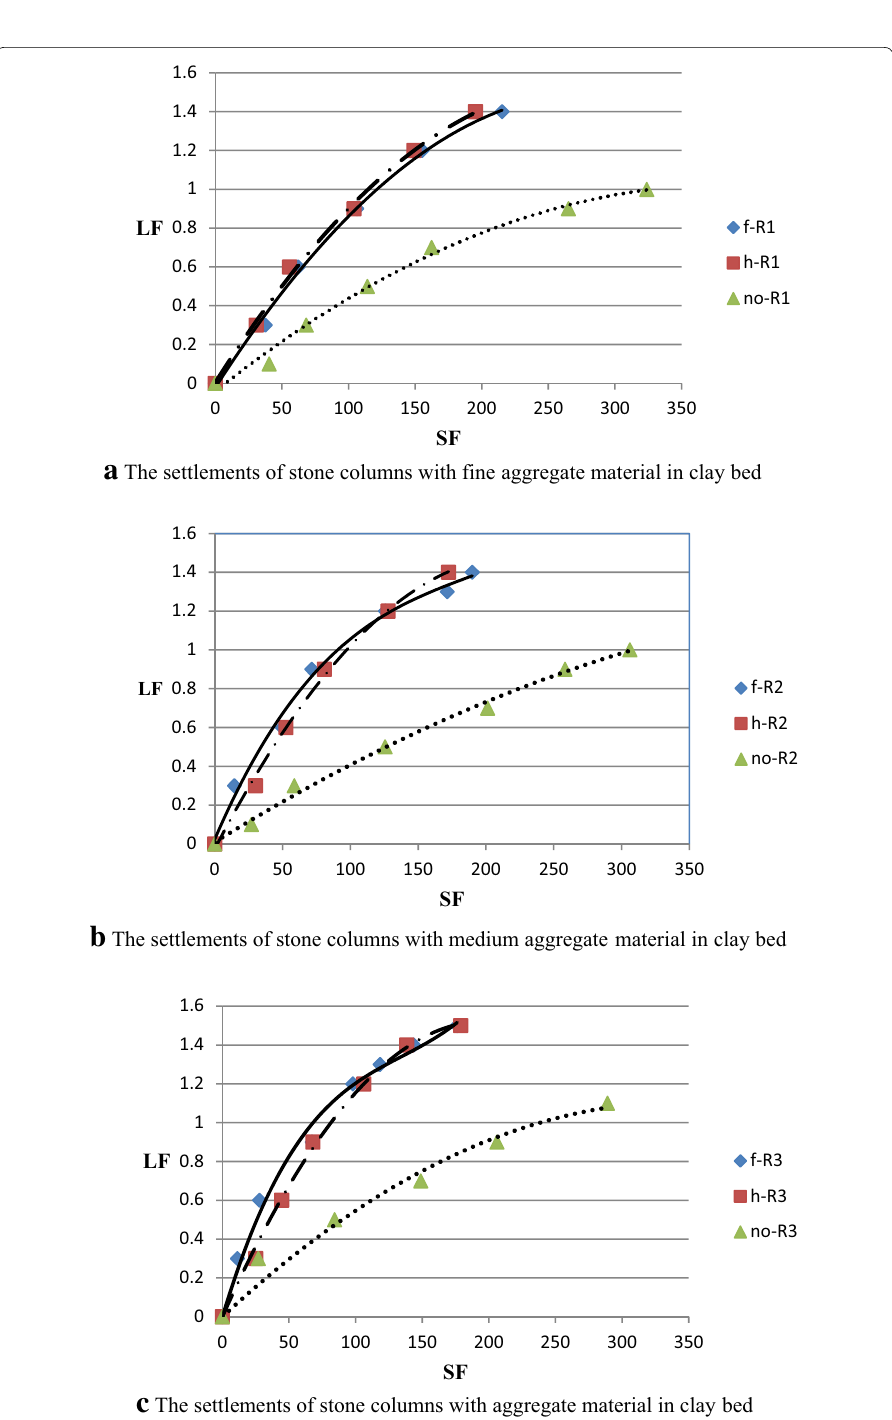
Fig. 6 Test results in clay bed for different lengths of encasement and aggregate